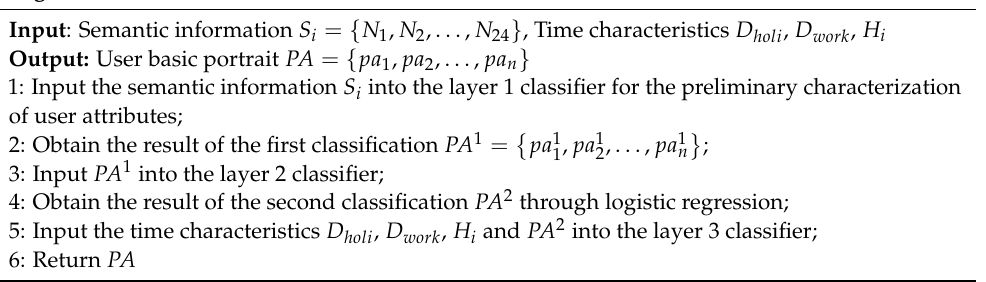
Algorithm 1 User Basic Portrait Generation